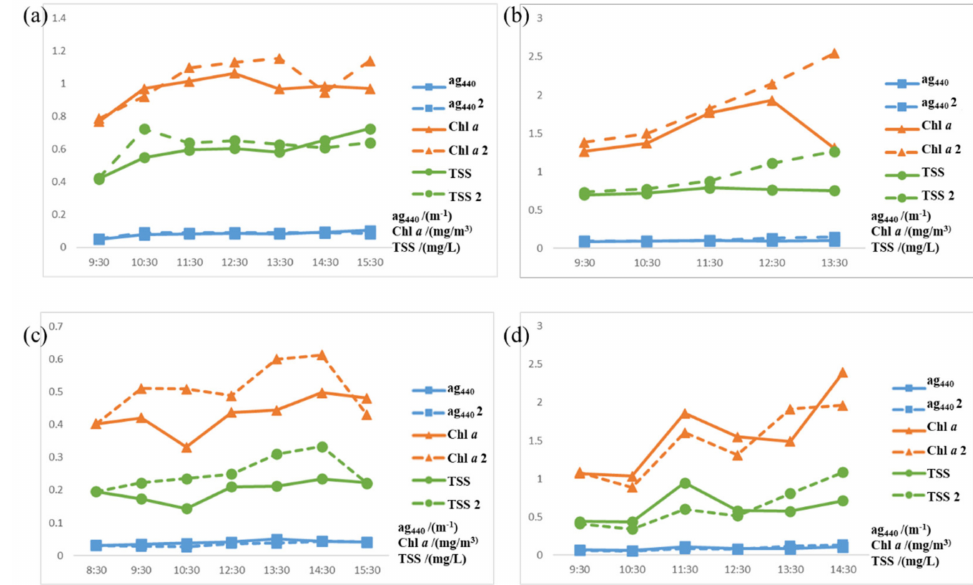
Figure 6. Comparison of four typical groups of diurnal time series. The dashed lines represent the fixed-location monitoring results using the traditional Eulerian method, and the solid lines represent the results of the proposed method. ( a ) Time series near Buoy No. 2 on 16 July 2012; ( b ) time series near Buoy No. 2 on 5 August 2012; ( c ) time series near Buoy No. 3 on 13 August 2012; and ( d ) Time series near Buoy No. 7 on 10 August